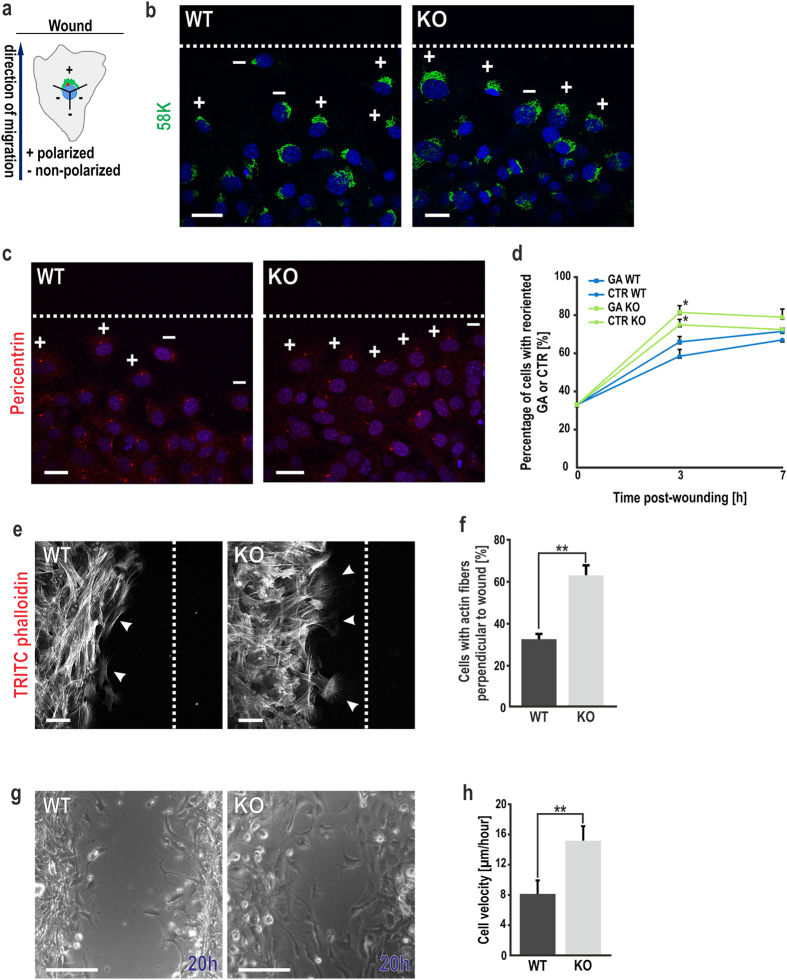
Cell polarization in migrating fibroblasts.(a) Schematic showing a cell with Golgi and MTOC positioned within a 120° sector, ( + ) polarized; (−) non-polarized. Blue arrow, direction of migration; black solid line, wound edge. (b–d) Scratch-wounded WT and KO fibroblasts stained for (b) Golgi (58K, green) and (c) centrosome (Pericentrin, cyan) 3 h post-wounding. Nuclei stained with DAPI (blue). The position of the leading zone (broken white line) shown. Scale bar = 25 μm. Line chart (d) showing percentage of cells with reoriented Golgi and MTOC (n = 100 cells each time, each condition, 2 independent experiments; *P < 0.05). (e) TRITC-phalloidin staining of wounded cell layers (red false-coloured as grey) to visualize the F-actin network. White arrowheads, orientation of the actin fibres (parallel in WT and perpendicular in KO). Scale bar = 50 μm. (f) Bar graph with percentage of cells at the wound edge with a polarized distribution of F-actin i.e., perpendicular to leading edge (n = 100 cells each, 2 independent experiments; **P < 0.01). (g) Analysis of cell migration over 20 h for WT and KO fibroblasts. Scale bar = 100 μm. Frames from time-lapse phase-contrast videos at the indicated time shown. (h) Analysis of the velocity of single cells (in μm/hour). 10 cells from both WT and KO, per position and per edge were considered (n > 200 cells, 5 independent experiments; **P < 0.01). Data shown as mean ± SD.